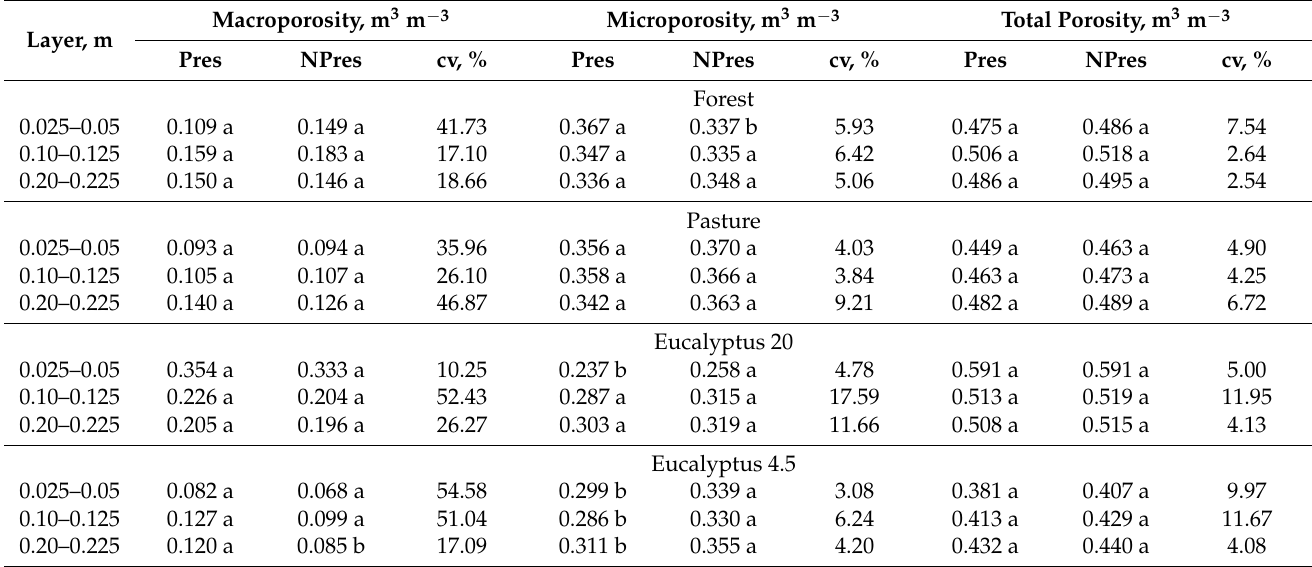
Table 2. Coefficient of variation (cv) and mean values of macroporosity, microporosity and total porosity, for soil with preserved (Pres) and non-preserved (NPres) structure under different land uses and